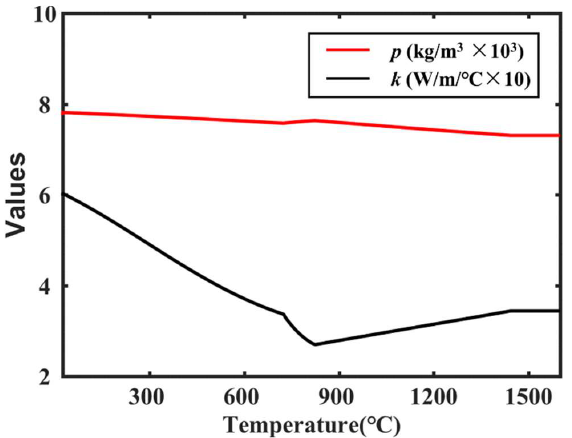
Figure 2. Temperature-dependent density and heat conductivity coefficient of 1700MS, data from ref. [17].